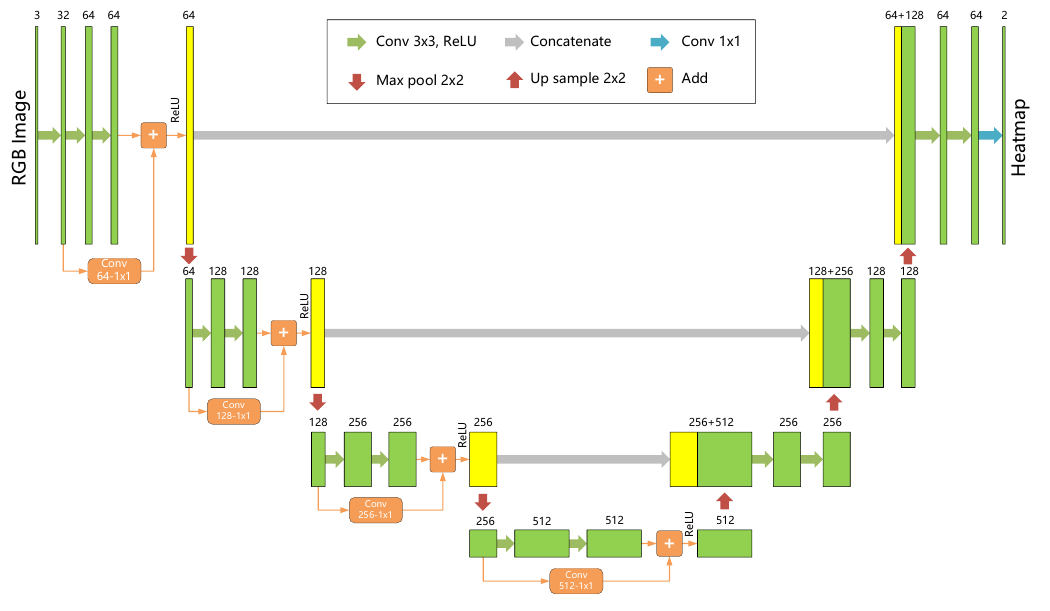
Figure 5. The architecture of P2HNet.